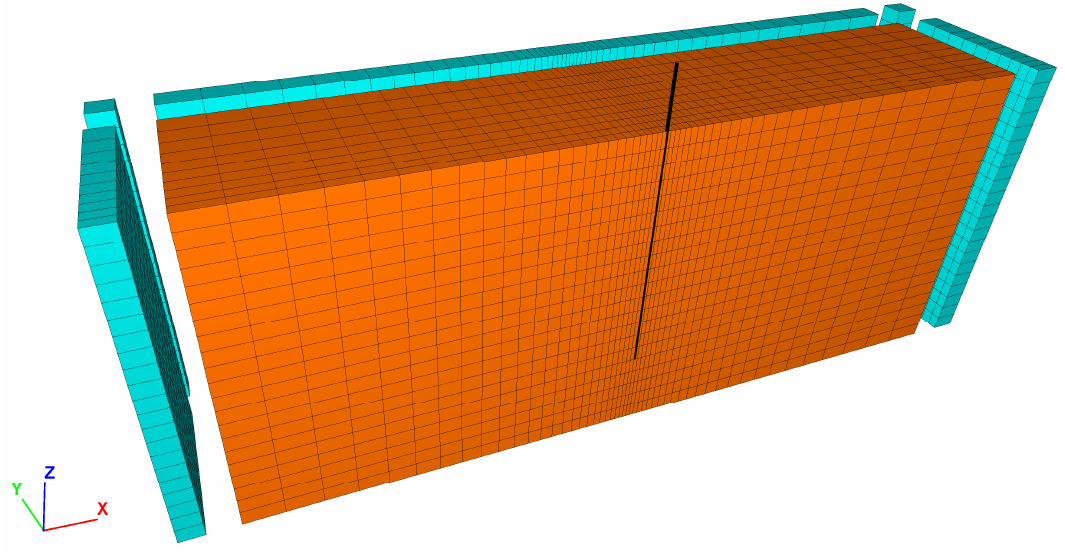
Figure 5. The numerical model created for the verification analyses (FLAC 3D ).